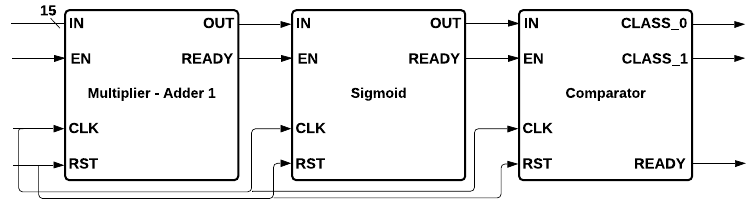
Figure 11. Logistic Regression Hardware